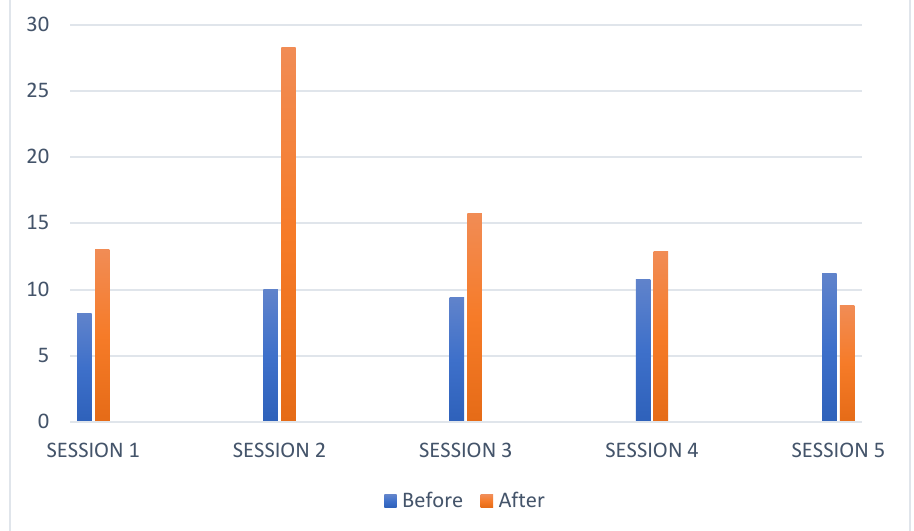
Figure 2. Participant 2 stress level bar chart.